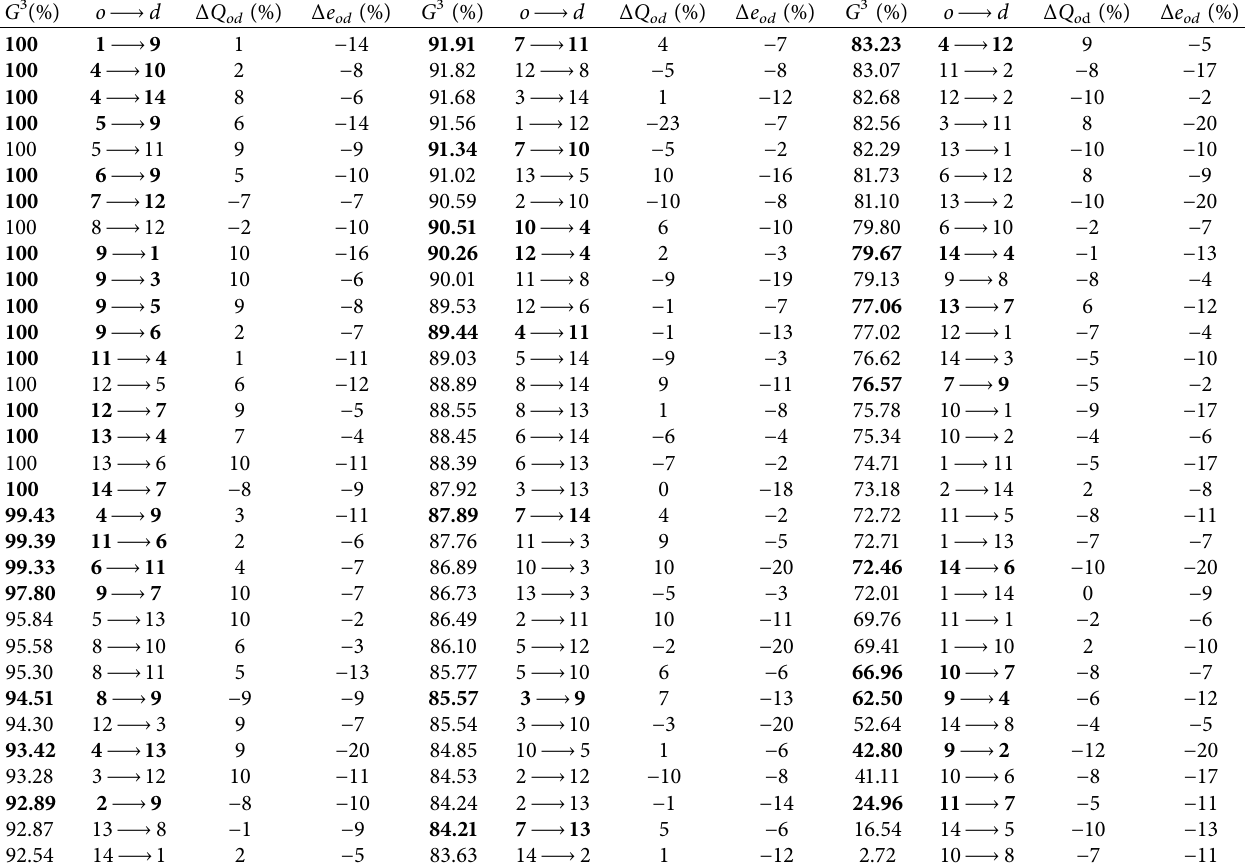
Table 3: The results of LSN in NO phase ( G 3